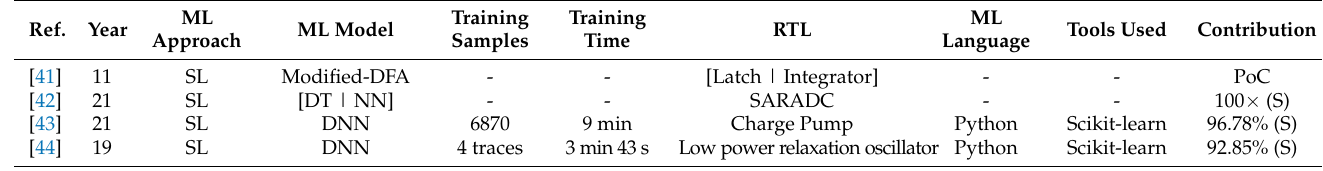
Table abbreviations key for: ML